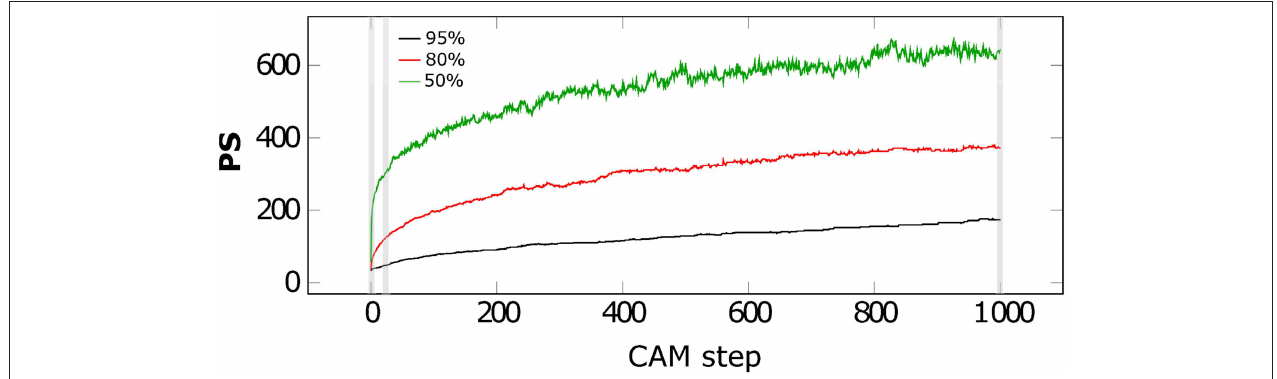
FIGURE 4 | Average particle sizes (PS) over CAM time steps for a composition of 6%Gt/6%Il neg /88%Qz for porosity of 50% (green), 80% (red), and 95% (black). The gray shaded areas correspond to three time steps shown in Figure 5